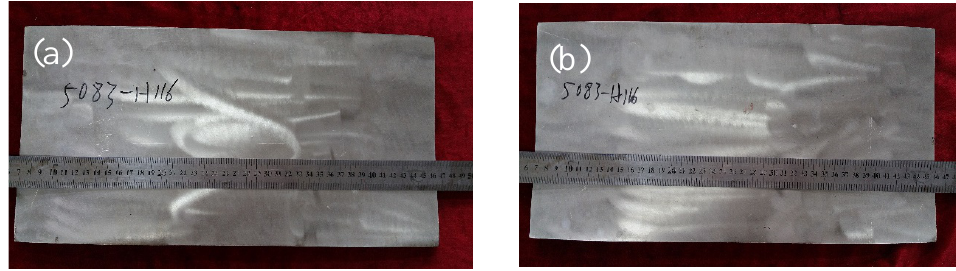
Figure 2. Front of test panel: ( a ) flame straightening; ( b ) synchronous water-cooling.